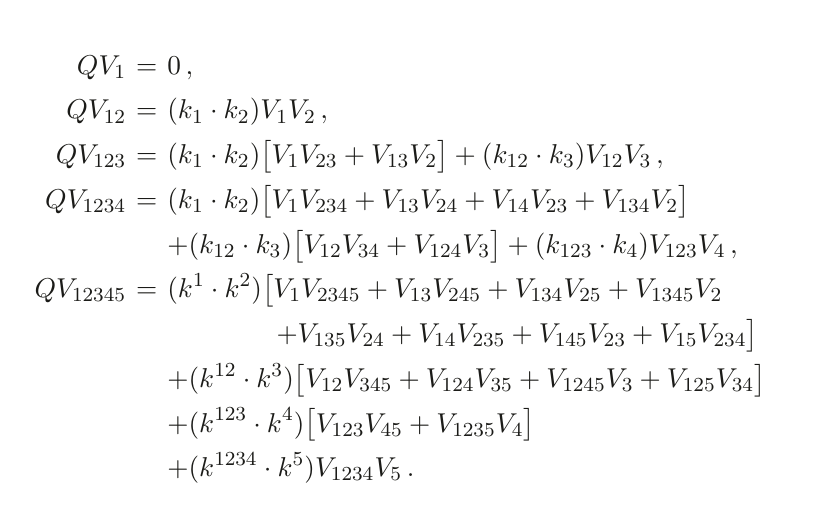
of kinematic numerators subject to the BCJ duality. They can be visualized as